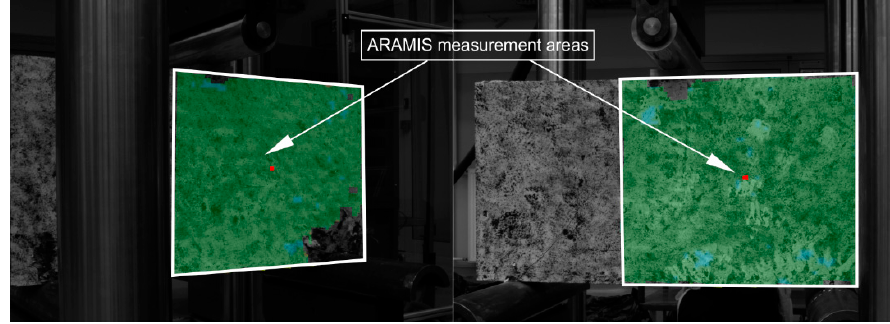
Figure 6. ARAMIS system measurement areas for deep beams (DB).